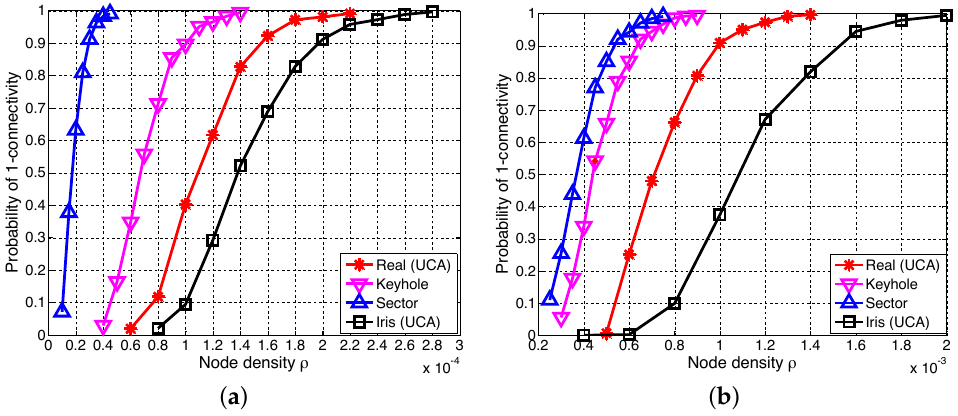
Figure 10. One-connectivity P ( 1-con ) of UCA antenna, keyhole, sector and iris-UCA models. ( a ) α = 2.5, σ = 4; ( b ) α = 3, σ =